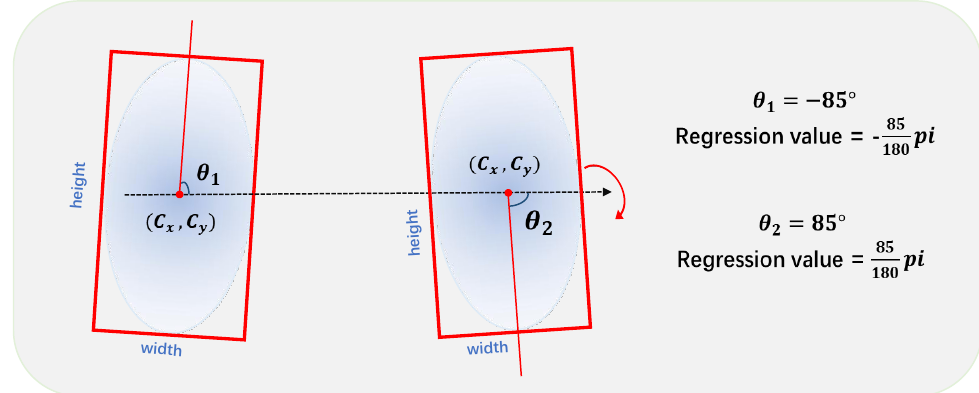
Figure 4. An example of discontinuous angular boundary based on the five-parameter long side